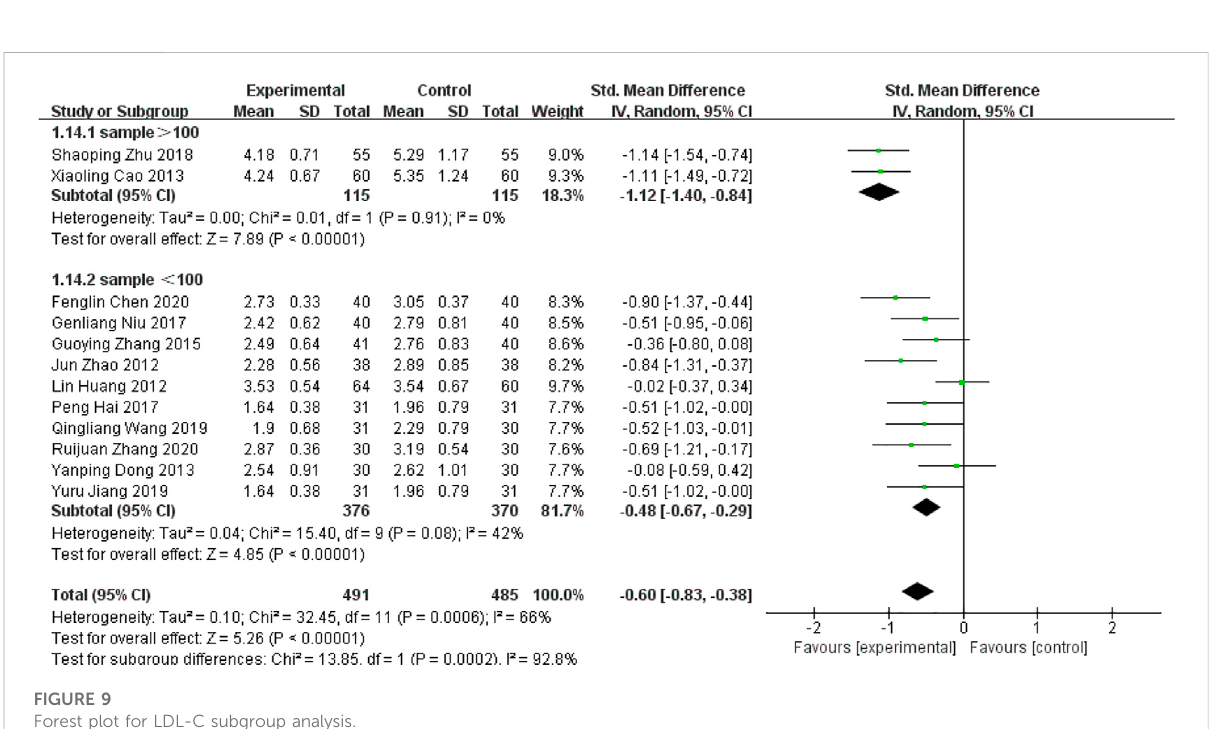
FIGURE 9 Forest plot for LDL-C subgroup